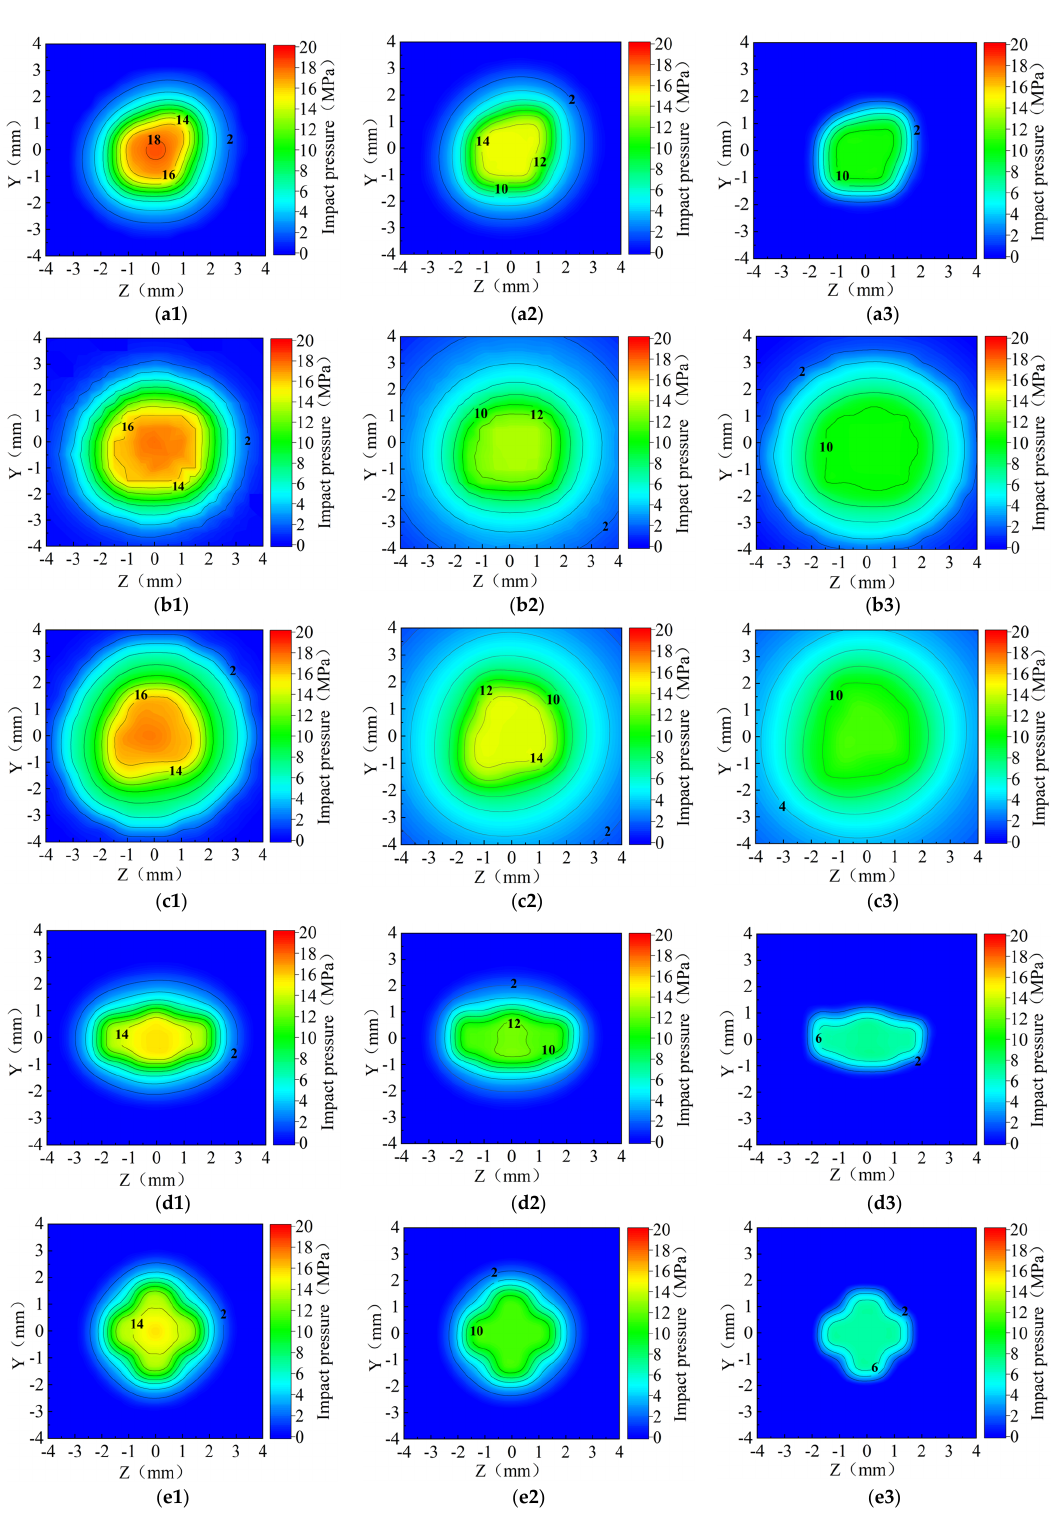
Figure 11. Water jet impact area at different target distances: ( a1 ) circular nozzle, x = 40; ( a2 ) circular nozzle, x = 100; ( a3 ) circular nozzle, x = 160; ( b1 ) square nozzle, x = 40; ( b2 ) square nozzle, x = 100; ( b3 ) square nozzle, x = 160; ( c1 ) triangular nozzle, x = 40; ( c2 ) triangular nozzle, x = 100; ( c3 ) triangular nozzle, x = 160; ( d1 ) elliptical nozzle, x = 40; ( d2 ) elliptical nozzle, x = 100; ( d3 ) elliptical nozzle, x = 160; ( e1 ) cross nozzle, x = 40; ( e2 ) cross nozzle, x = 100; ( e3 ) cross nozzle, x = 160. When the target distance is x = 40 mm, the center impact pressure of the circular nozzle is the greatest, andcan reach more than 18 MPa, whereas the maximum pressure of other nozzles does not exceed 18 MPa, especially the elliptical and cross nozzles, where the maximum center impact pressure can be observed to belowerthan 16 MPa by comparing Figure 11a1–e1.The pressure decay wasimpacted within 20%, that is, P ≥ 16 MPa, when calculating the effective impact area. S tri > S squ > S cir , the effective area of the triangular nozzle was 1.86 times higher than that of the circular nozzle, and that of the square nozzle was 1.71 times higher than that of the circular nozzle. The pressure decay wasimpacted within 30%, that is, P ≥ 14 MPa, when calculating the effective impact sur- face. The effective impact area of the triangular nozzles wasstill the largest, at 1.88 times higher than that of the circular nozzle. The order was S tri > S squ > S cir > S ell > S cro . When the target distance x = 100 mm, the maximum impact pressure of the circular and triangular nozzles wasmore than 14 MPa, and the effective impact area of the trian- gular nozzle was 1.61 times higher than that of the circular nozzle by comparing Figure 11a2–e2. The effective impact area wascalculated to be P ≥ 12 MPa, and the order was S tri > S squ > S cir > S ell . The effective area of the triangular nozzle was 1.69 times higher than that of the circular nozzle, and the maximum impact pressure of the cross nozzle didnot reach 12 MPa. When the target distance x = 160 mm, the maximum impact pressure of the five nozzles decreased remarkably, as can be observed by comparing Figure 11a3–e3. The maximum impact pressure of circular, triangular, and square nozzles wasmore than 10 MPa, and the effective impact area of the triangular nozzlewasstill the largest, followed by the square nozzle, and the circular nozzlewasthe smallest, at P ≥ 10 MPa. The maxi- mum impact pressure of the elliptical and cross nozzles decayedthe most rapidly, only reaching 6 MPa.